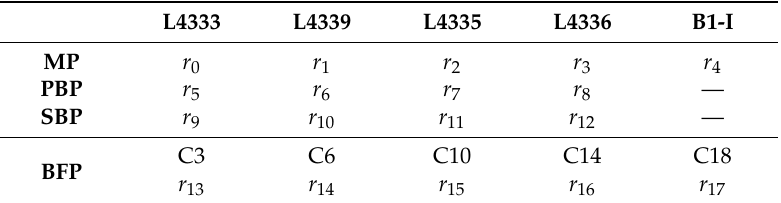
Table 3. The Encoding of Relays.